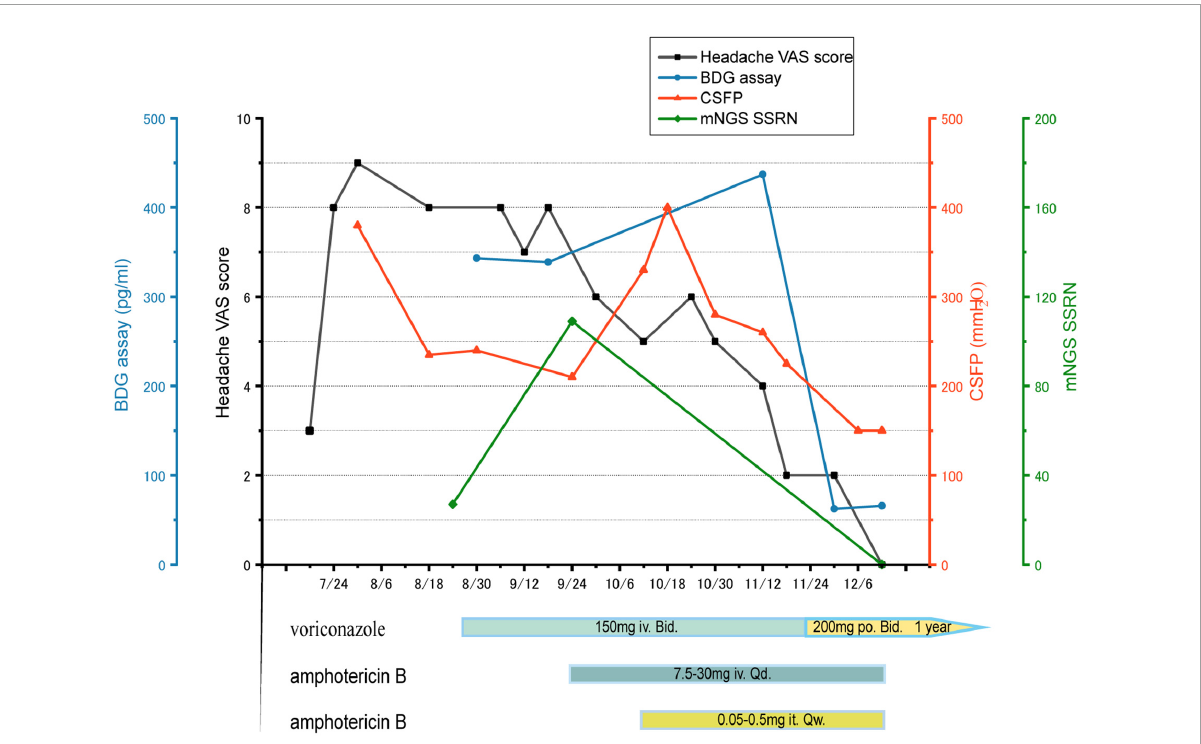
FIGURE1 Headache VAS score (black), BDG assay (blue), CSFP (orange), mNGS SSRN (green). The treatment course: voriconazole iv for 4 weeks, but both of mNGS SSRN and CSFP increase, so intrathecal and intravenous amphotericin B were added, combined with voriconazole, for 8 weeks. Then voriconazole po for a year. VAS: visual analogue scale, BDG: (1-3)- β - D -glucan, CSFP: cerebrospinal fluid pressure, mNGS: metagenomic next-generation sequencing, SSRN: species-specific read number, iv: intravenous injection, po: per os , it: intrathecal